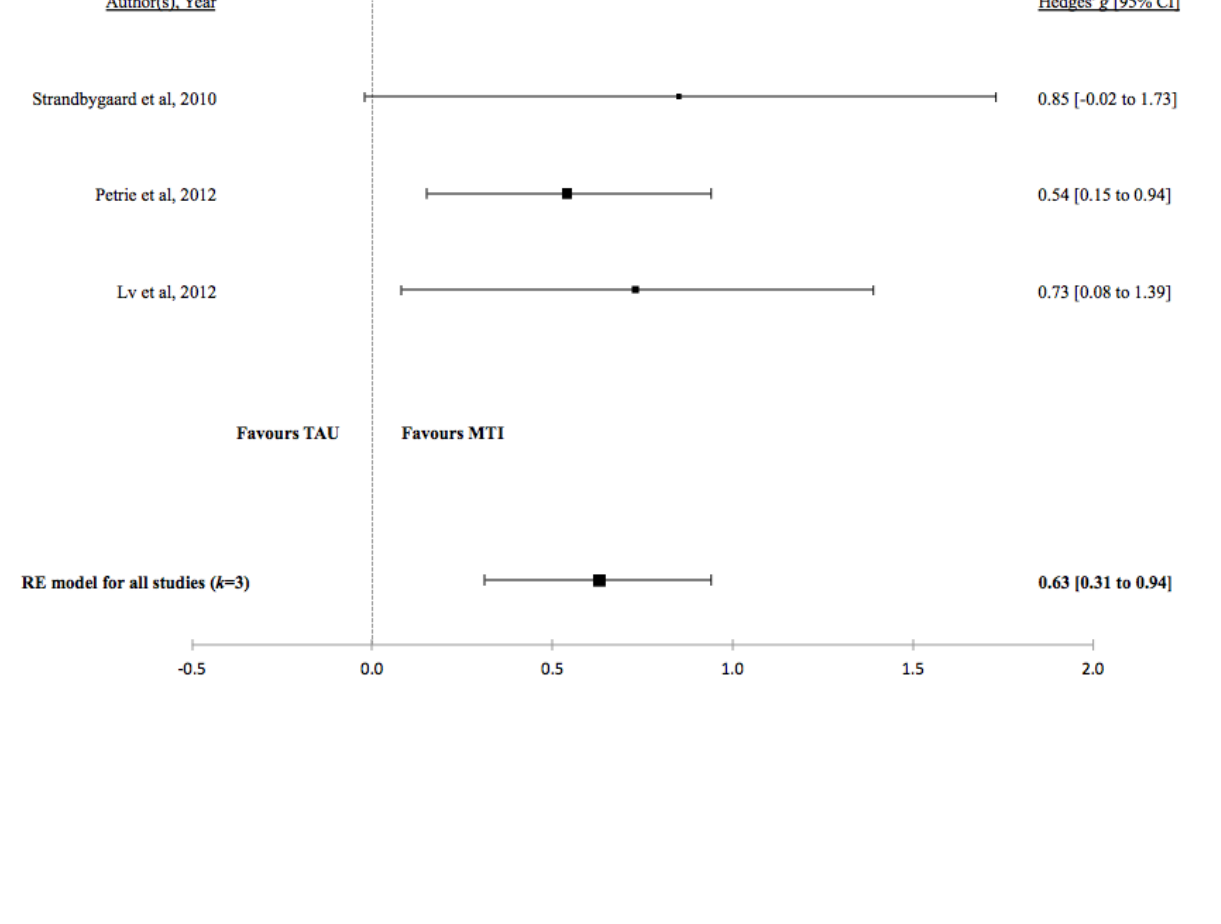
Figure 6. Forest plot of the standardized mean difference in medication adherence between MTI and standard treatment group. MTI: mobile technology